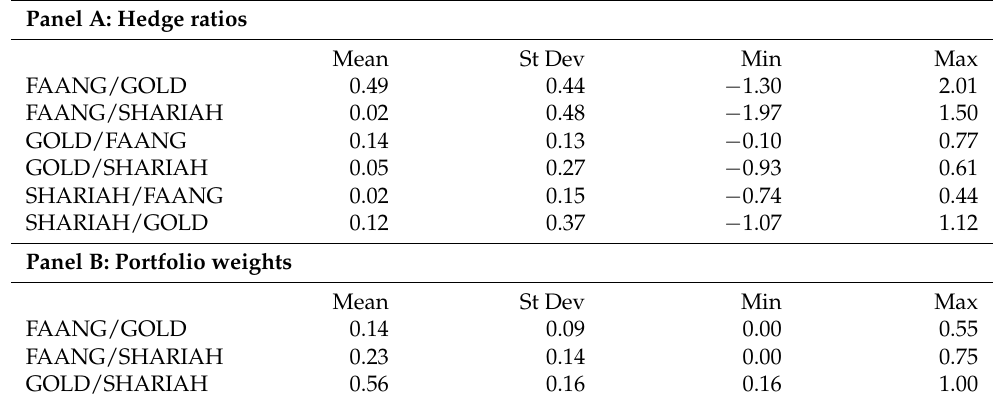
Table 4. Summary statistics of the hedge ratios (long/short) and portfolio